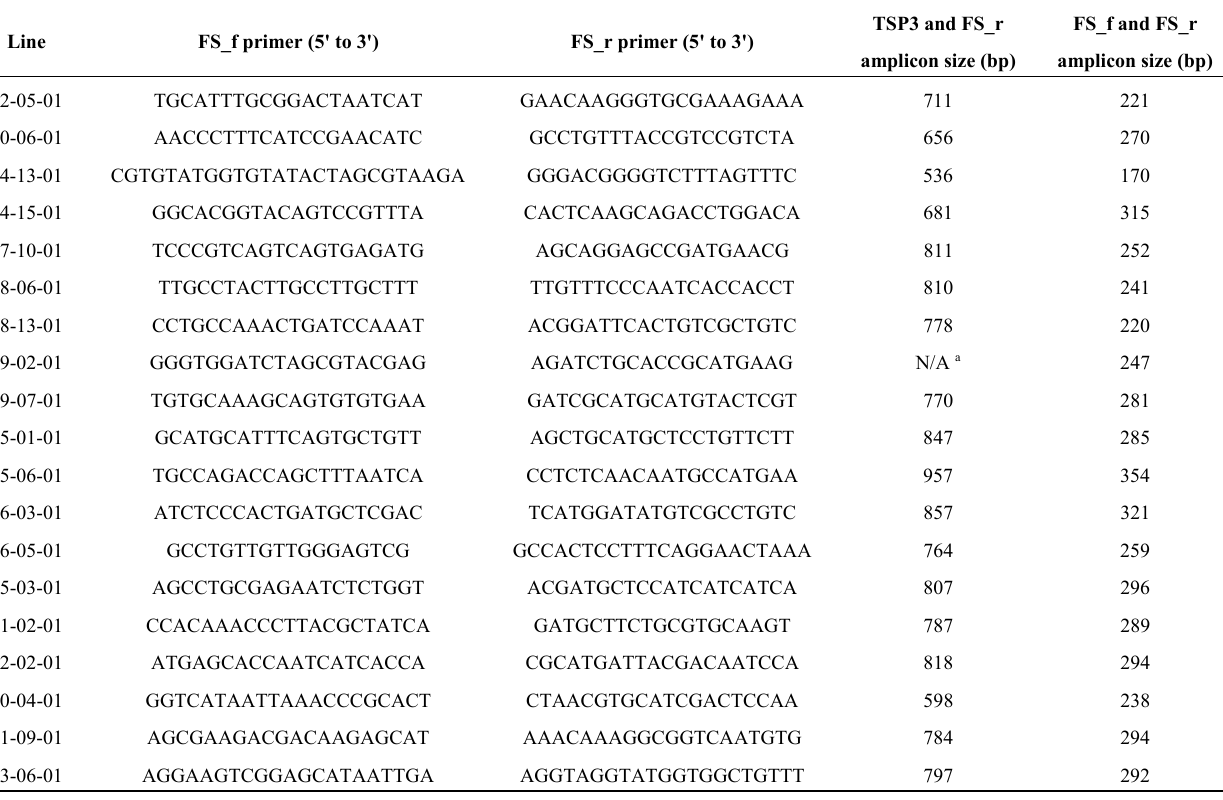
Table 1. The primers designed to anneal within the T-DNA flanking sequences which were used for junction sequence verification. The corresponding amplicon product sizes are given for the different primer combinations